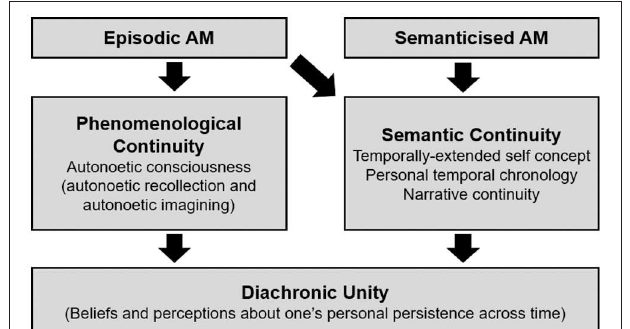
FIGURE 1 | Model of the temporally extended self, showing two autobiographical memory mechanisms for continuity, and their proposed relationship to diachronic